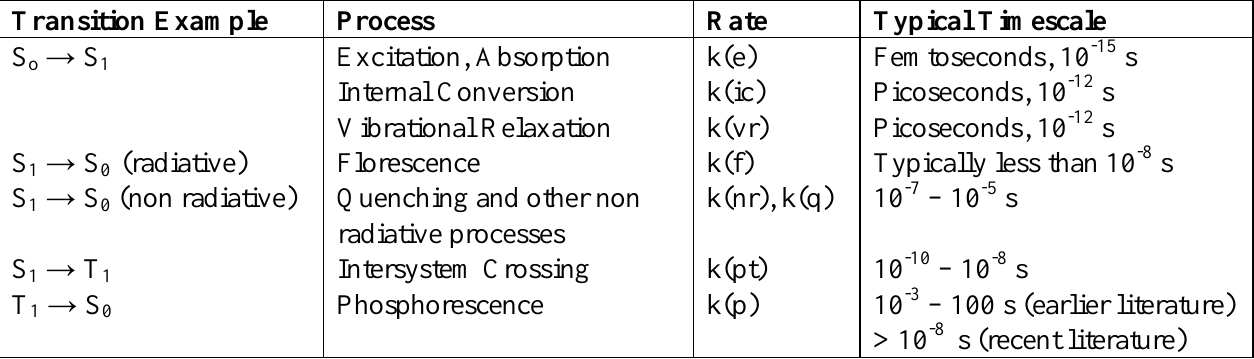
Table 2. Summary of typical process times from excitation to